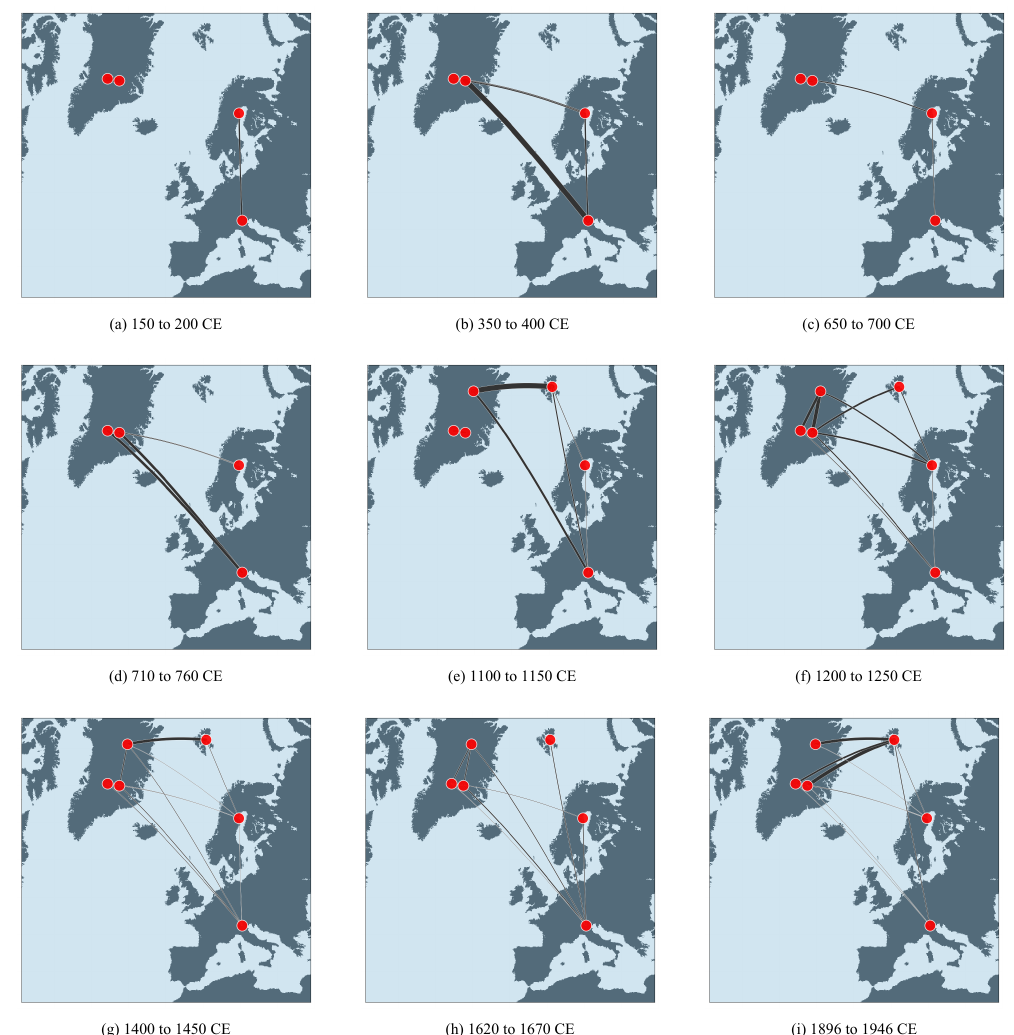
Figure 4. Simplified functional paleoclimate networks for different exemplary time windows illustrating the great variety of spatial connec- tivity patterns during the time interval covered by this study. The red circles indicate the centre of each group of records (only shown if any record of a cluster has values at the specific time window). The thickness of each link is proportional to the CLD of that connection. The time intervals have been chosen such that they demonstrate the general patterns of zonal and meridional connectivity. For a more objective analysis we employ a linear